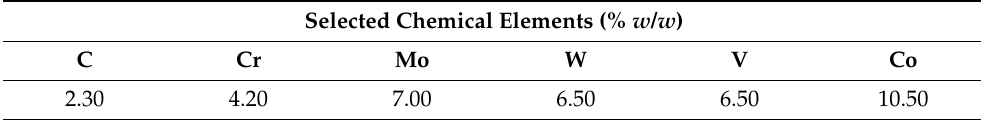
Table 1. The declared chemical composition of Vanadis60 SuperClean steel. Selected Chemical Elements (% w / w )